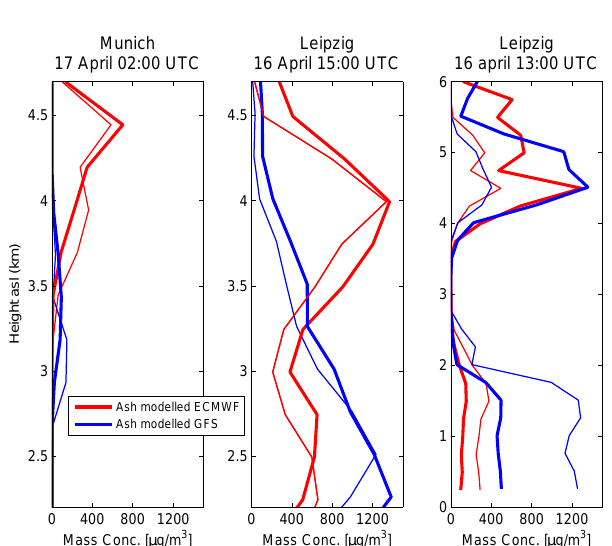
Fig. A7. Comparison of FLEXPART simulated and lidar observed ash cloud. FLEXPART simulated vertical distribution of ash, using ECMWF and GFS data based on both a priori (thin lines) and a posteriori (thick lines) emissions, over Munich (48.2 ◦ N, 11.3 ◦ E) on 17 April and over Leipzig (51.4 ◦ N, 12.4 ◦ E) on 16 April. To be compared with lidar observations (Figs. 4 and 5b in Ansmann et al.,